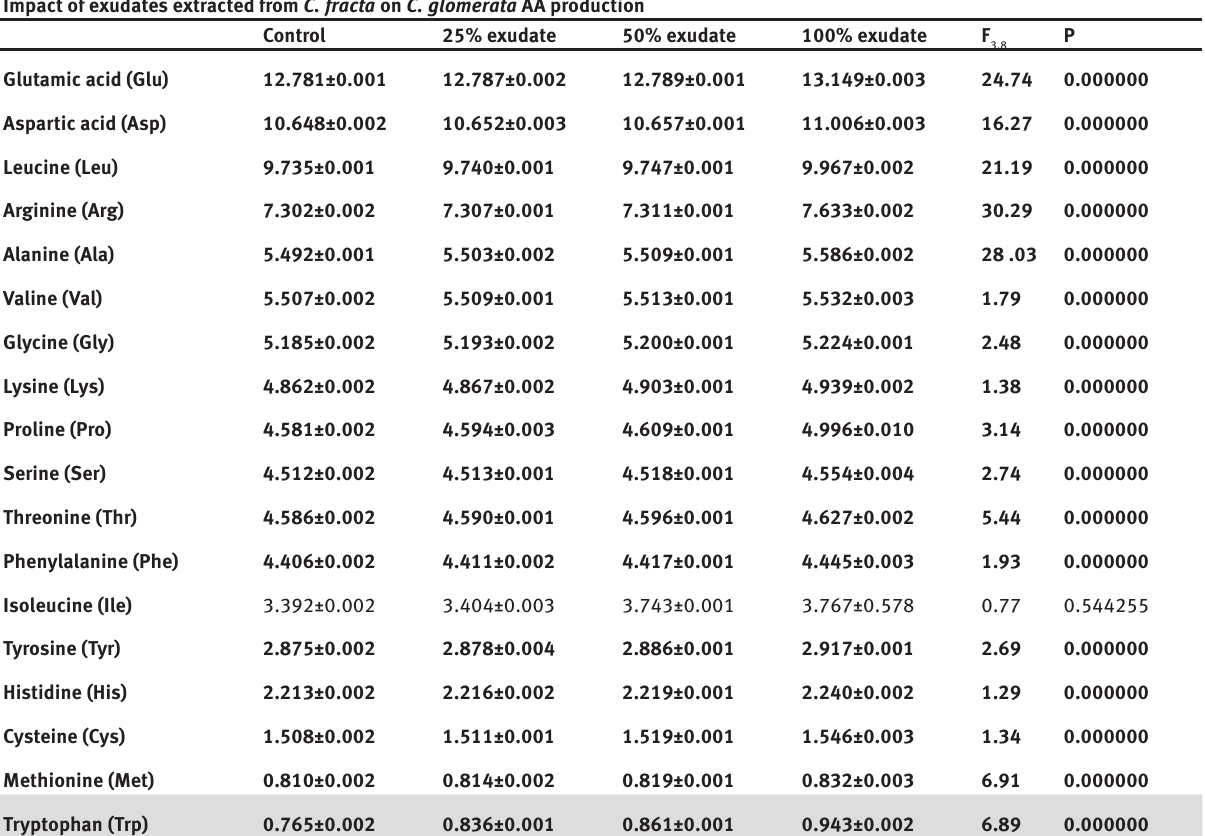
Table 3: The content of amino acids (AA) in Cladophora glomerata biomass (g·100g -1 of total proteins; df=3; bold - statistically significant, p<0.05; gray selection - fluctuation in the content of amino acid > 10%). Impact of exudates extracted from C. fracta on C. glomerata AA